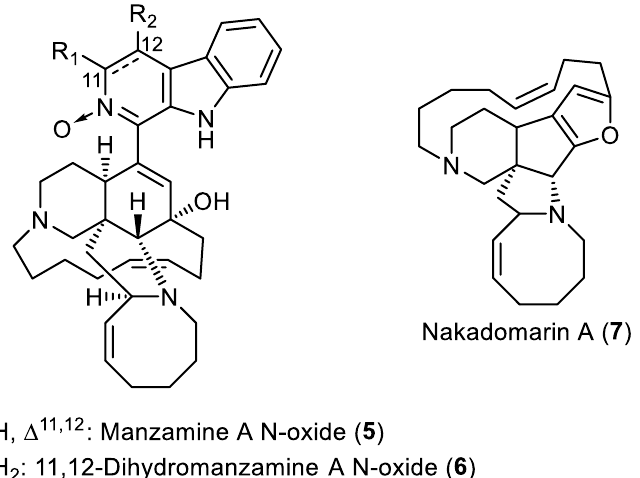
Figure 1. The chemical structures of the methanolic extract of Acanthostrongylophora ingens used in the in silico docking study.